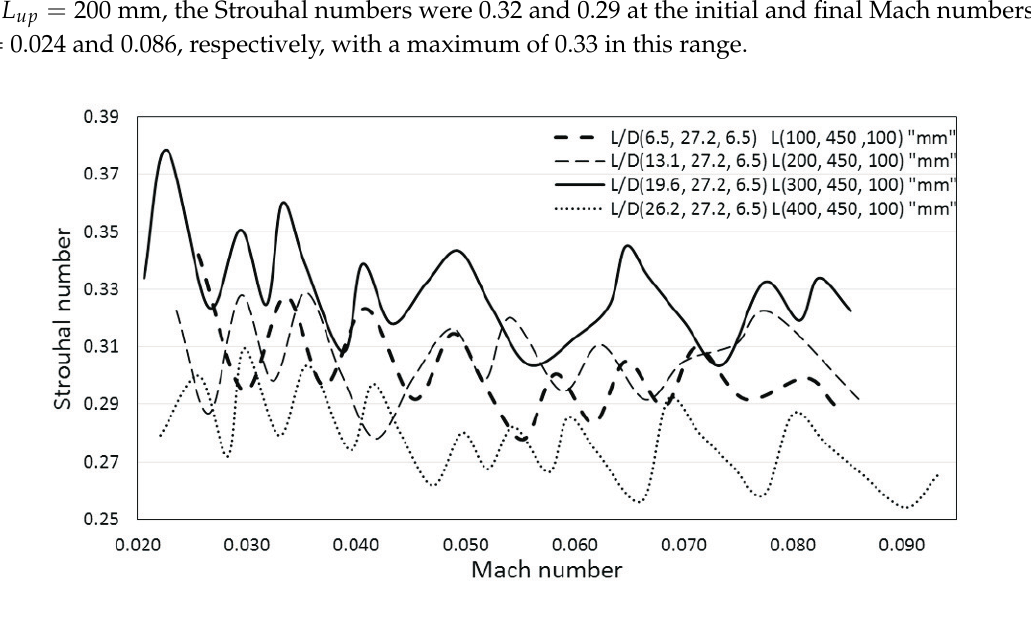
Figure 21. Strouhal number St plotted against Mach number M for L up = 100 mm, L corr = 450 mm, and L dw = 100–400 mm. Table 17. Mach number range, corresponding Strouhal number ( St ) range and maximum Strouhal number for each pipe configuration in Case